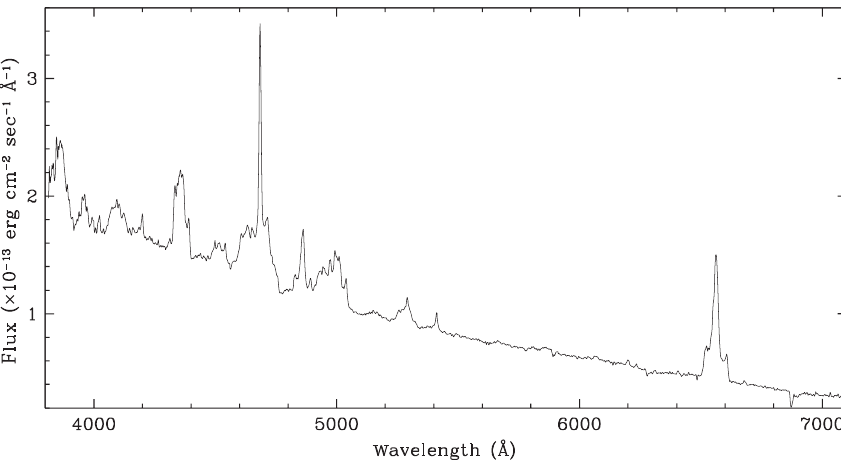
Fig. 2. ANS low resolution spectrum of Nova KT Eri 2009 on 2010 February 2, when the object was at B = 11.46, V = 11.53, R C = 11.37, I C = 11.27 and was declining from the outburst maximum peaking at V = 5.4 on 2009 November 14.7. The presence of a cool giant, the orbital period (cid:24) 2 years (Jurdana-ˇSepi´c et al. 2012) and the high ionization emission lines of [Ne V] and [Ne III], probably present in quiescence (Nesci et al. 2009), make this recent nova likely a new symbiotic star.